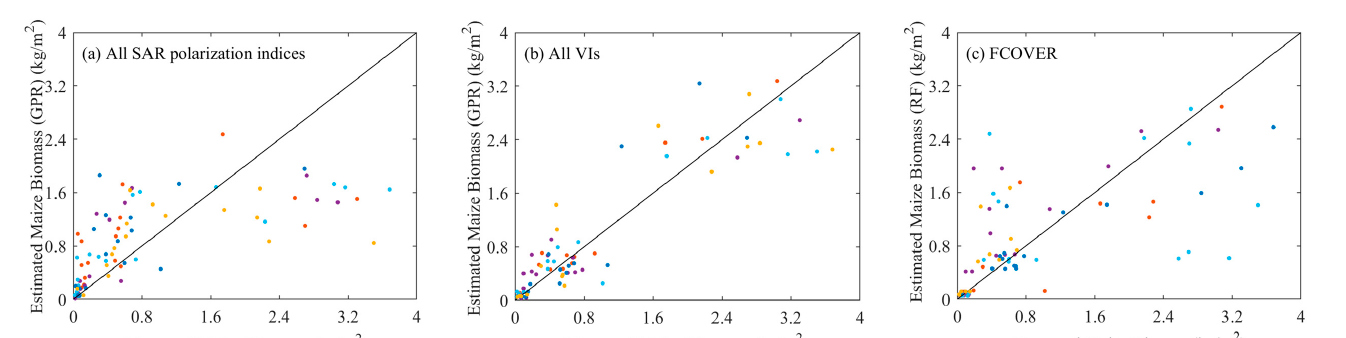
Figure 4. The logarithmic σ of GPR models with different groups of input predictors. The slash-filled bars in Figure 4 were the final input variables for each group of data optimized by the stepwise elimination method. The accuracies retrieved by GPR models with the optimal input variables are listed in Table 6. (VH + VV)/(VH × VV), VH + VV, and VH were selected as the most important input variables among the S-1 data, this selection did not yield more accurate estimates than all SAR polarization indices. The optimal var- iables among VIs were EVI, RVI, and SAVI. The GPR associated with three variables out- performed the models based on all VIs, enhancing R 2 from 0.77 to 0.80 and RMSE from